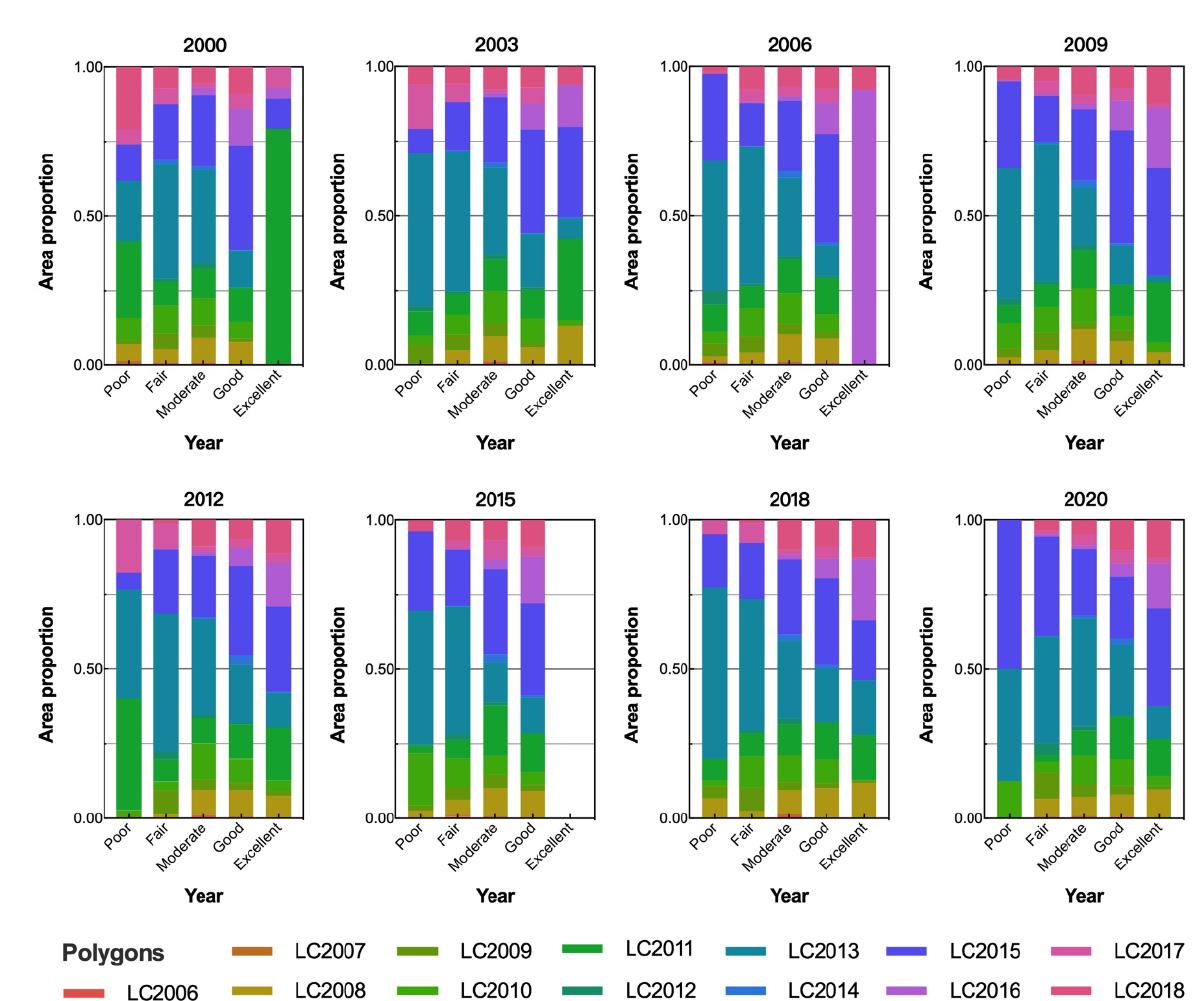
Figure A1. The area proportion of FC phases at each EEQ level in selected years.